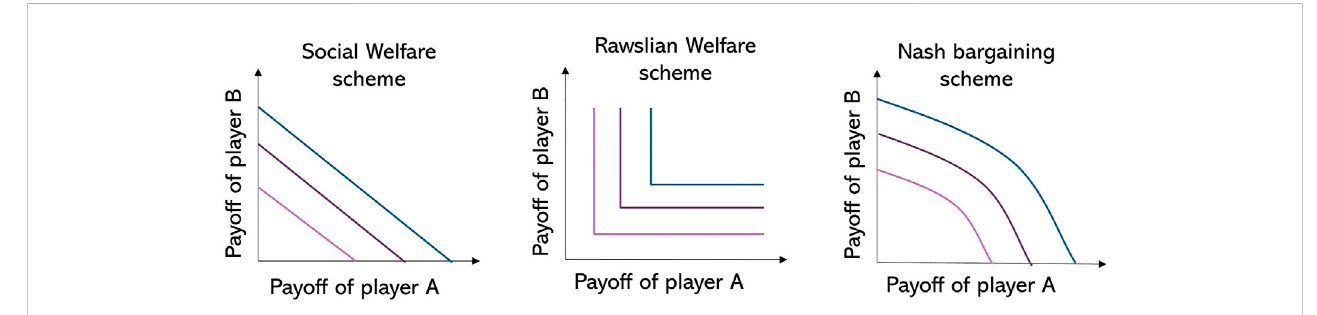
FIGURE 4 Payoff allocation for a two-player game under different fairness schemes. Pink contour corresponds to smaller total payoffs for both players, purple contour corresponds to higher payoffs, blue contour corresponds to the highest